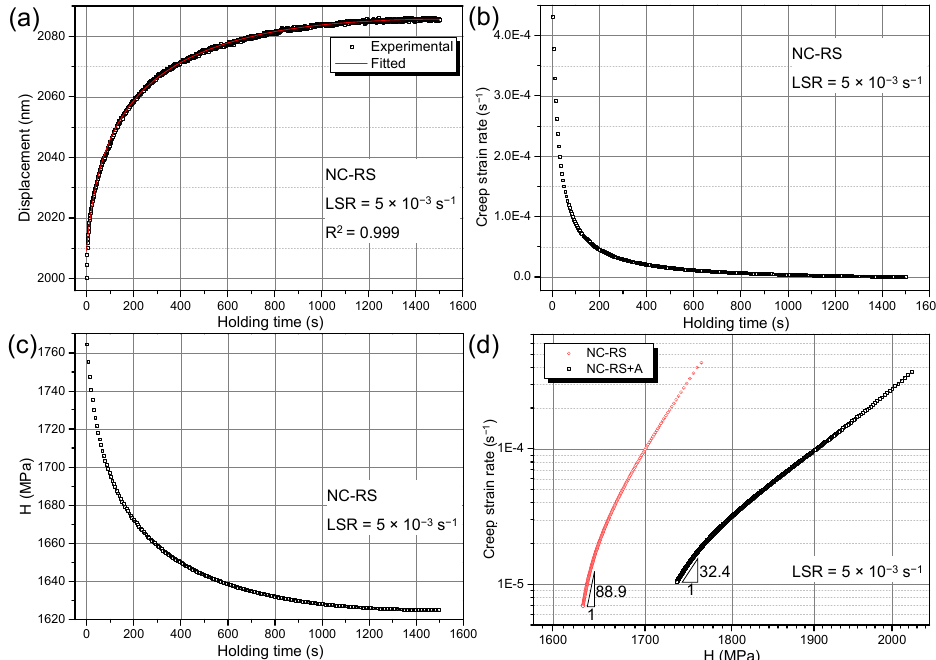
Figure 10. General procedures for calculating creep stress exponent n via nanoindentation tests: ( a ) h - t curve; ( b ) 𝜀(cid:4662) - t curve; ( c ) H - t curve; ( d ) log 𝜀(cid:4662) -log H curves.